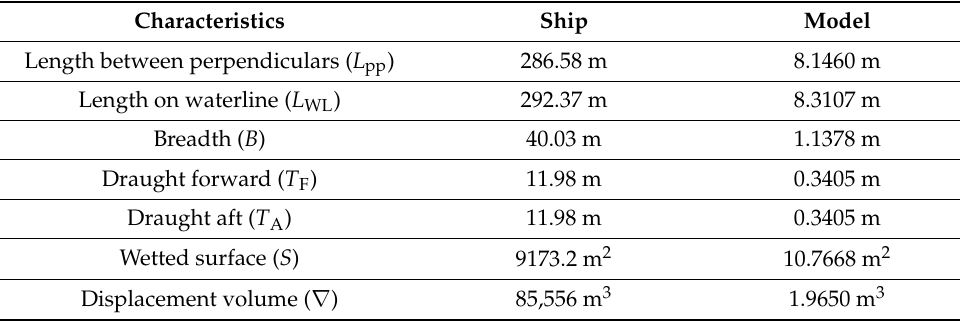
Table 2. The main characteristics of the model and the ship’s propeller in full size (full-scale propel- ler) (Source: Brodarski institut in Zagreb).